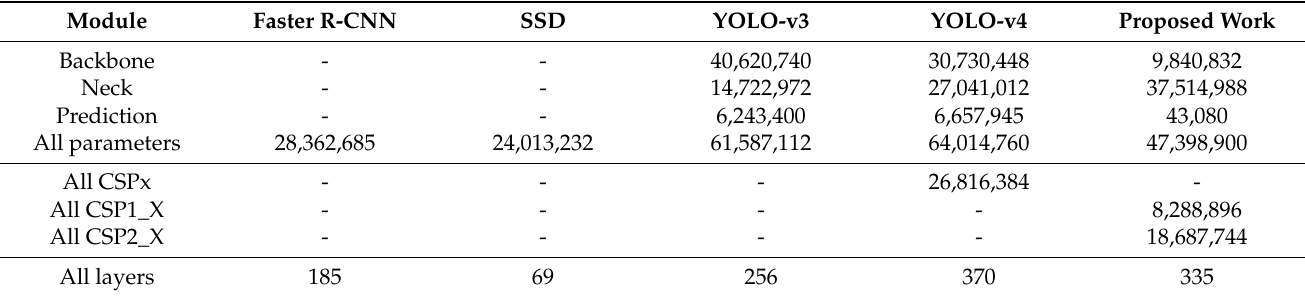
Table 7. The parameter distribution of different modules in different